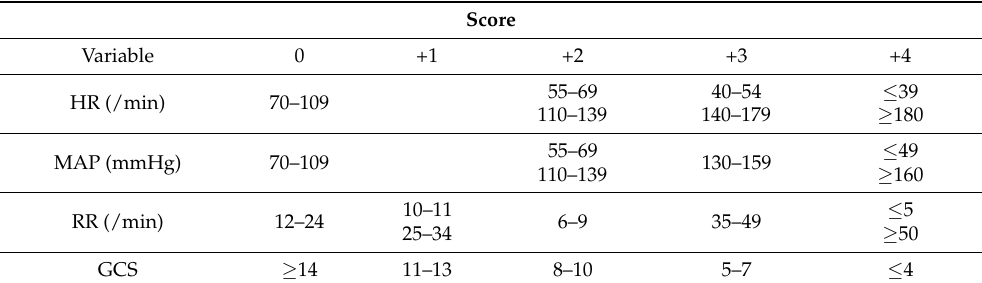
Table 2. Rapid Acute Physiology Score (RAPS) [22].